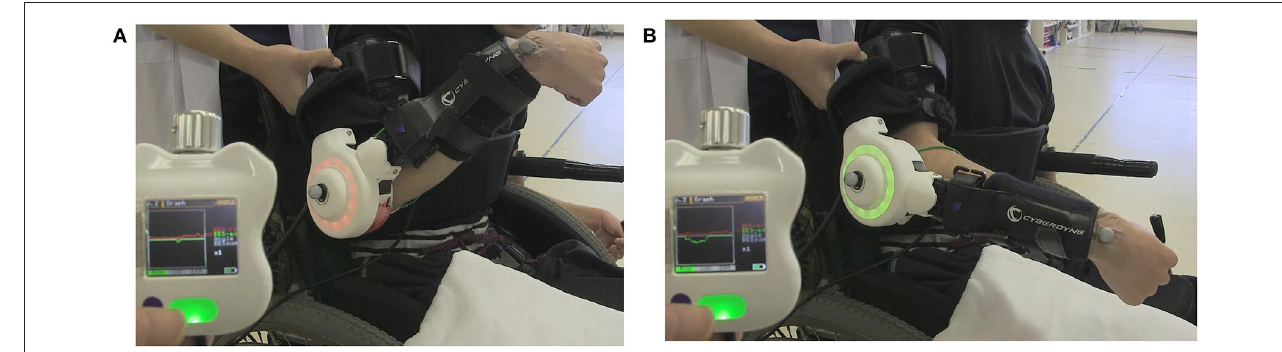
FIGURE 1 | The first HAL intervention in Case 1. During the session, a therapist supported the patient’s arm. The display of the controller shows bioelectric signals from the right bicep for elbow flexion as a red line, and those from the triceps for elbow flexion as a green line. The HAL elbow joint flashed a red light when the HAL was flexed and green when extended. (A) Voluntary flexion was intended with the HAL. (B) Extension was intended.